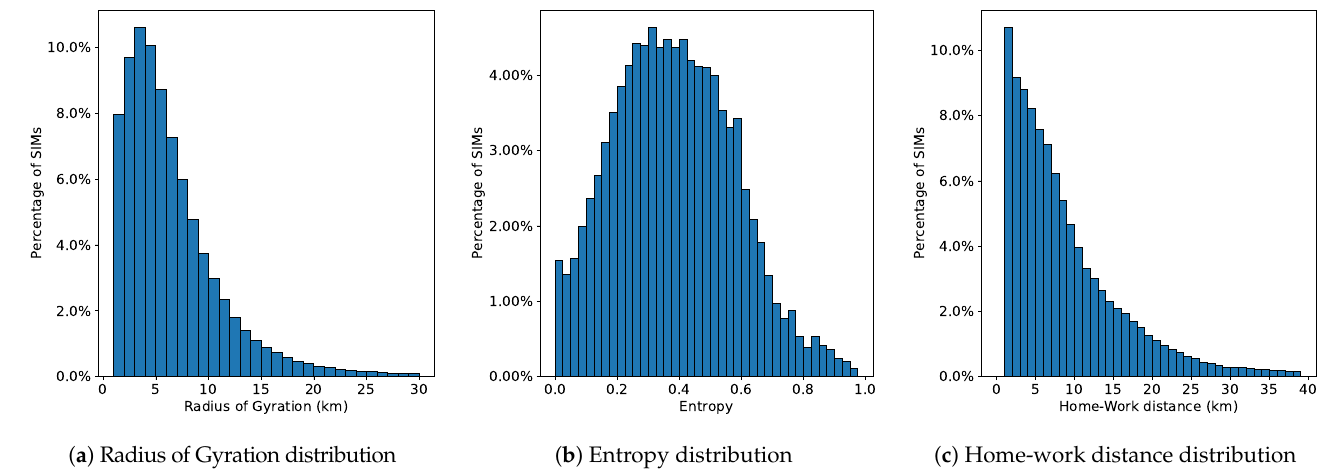
Figure 11. Histogram of the Radius of Gyration ( a ), Entropy ( b ) and the Home–Work location distance ( c